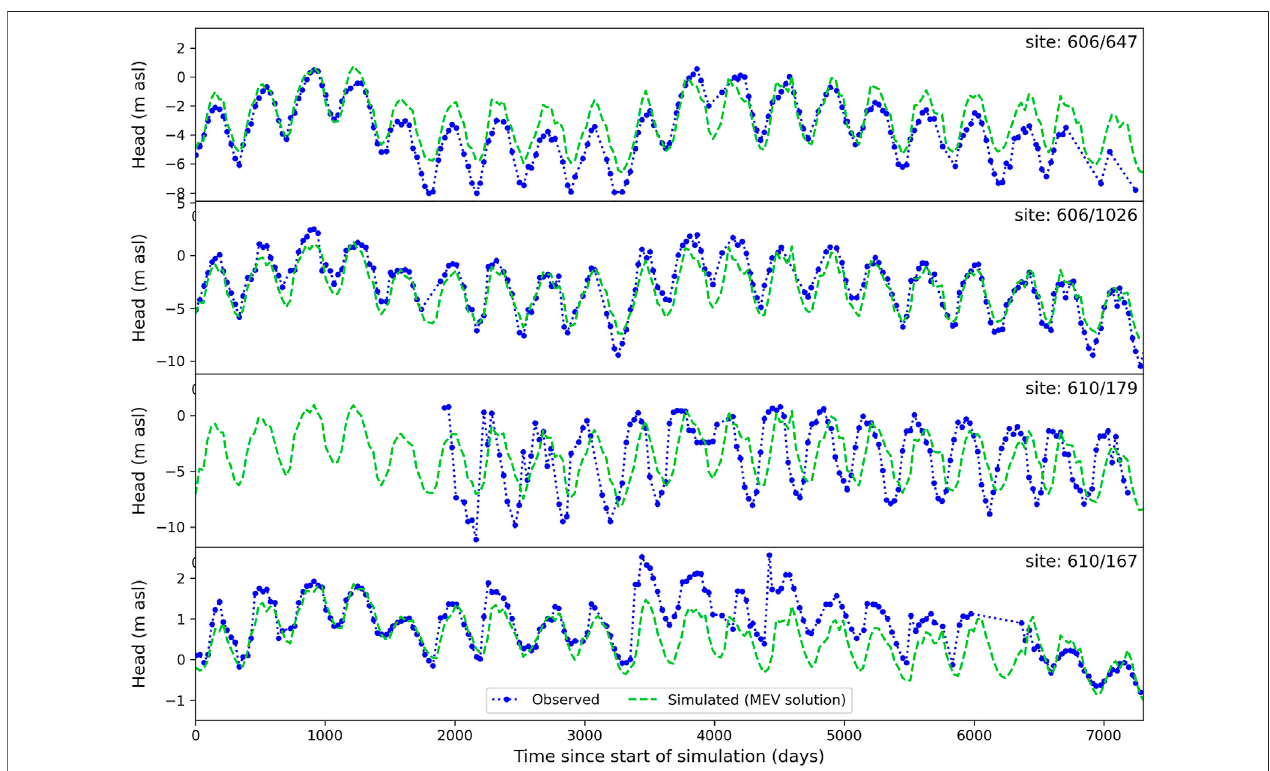
FIGURE5| Measured and simulated hydraulic headsfor 606/647, 606/1026 and610/179 from thesemi-con fi ned aquifer,and 610/167 from thephreatic aquifer.